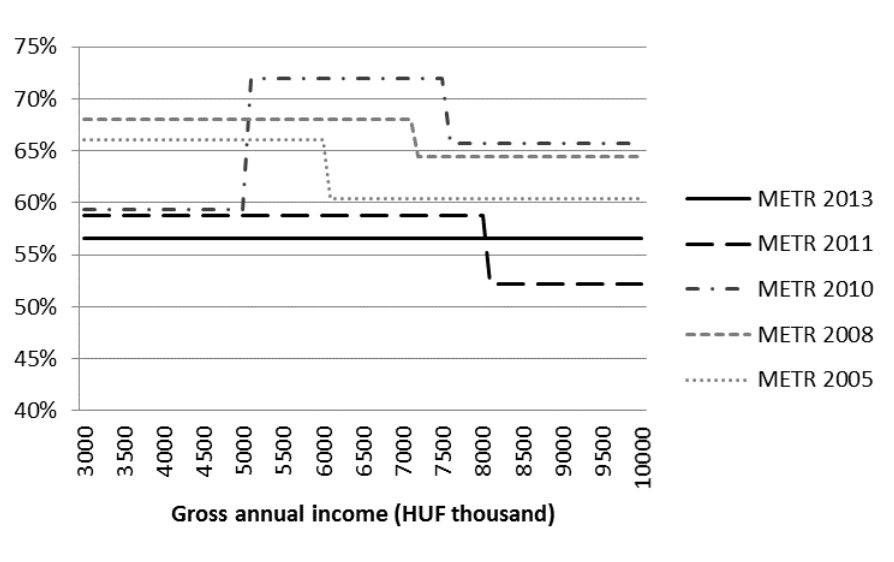
Figure A1. Marginal effective tax rates (METR) at high incomes in Hungary, 2005—